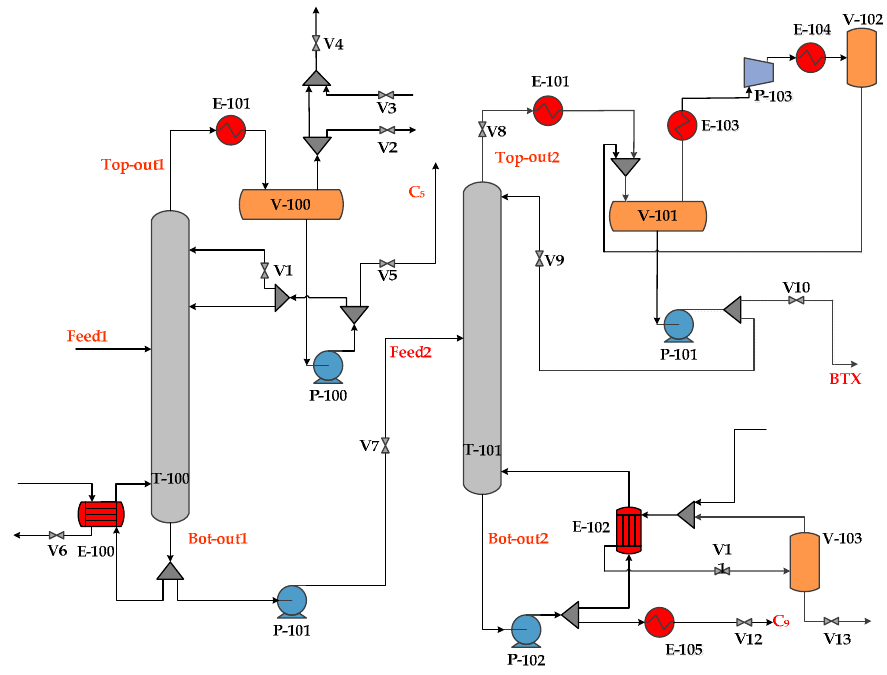
Figure 7. The flow chart of hydrogenation prefractionation system.